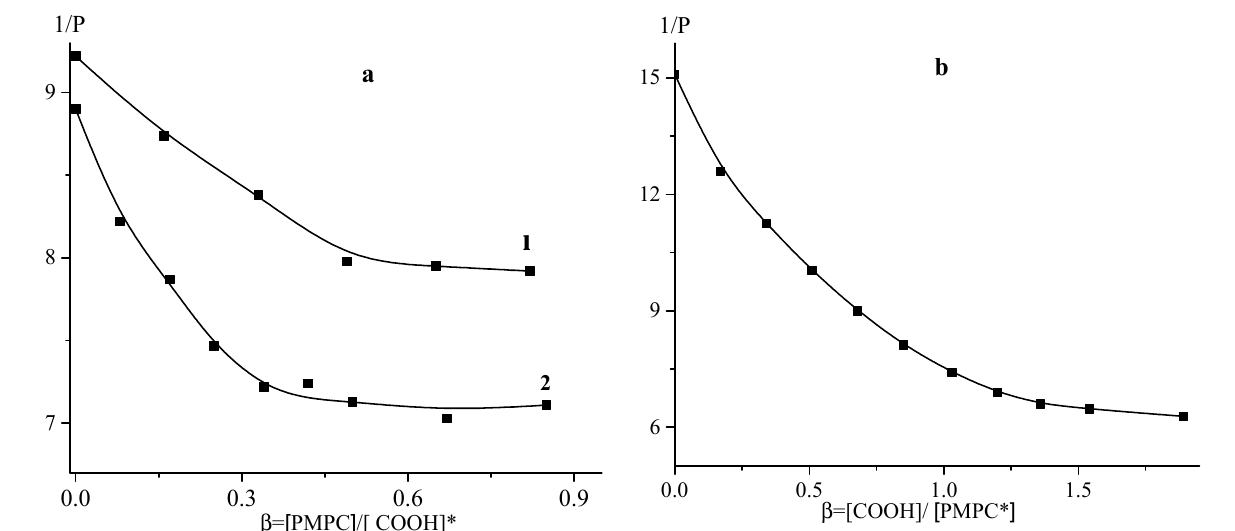
Figure 1. ( a ) Dependences of the 1/P values of an aqueous solution of PMAA* (1) and MAG-MAA 70 * copolymer (2) upon addition of PMPC on the ratio between components β = [PMPC]/[COOH*]; ( b ) dependence of the 1/P value of an aqueous solution of PMPC* upon addition of PMAA on the ratio between components β = [COOH]/[PMPC*].